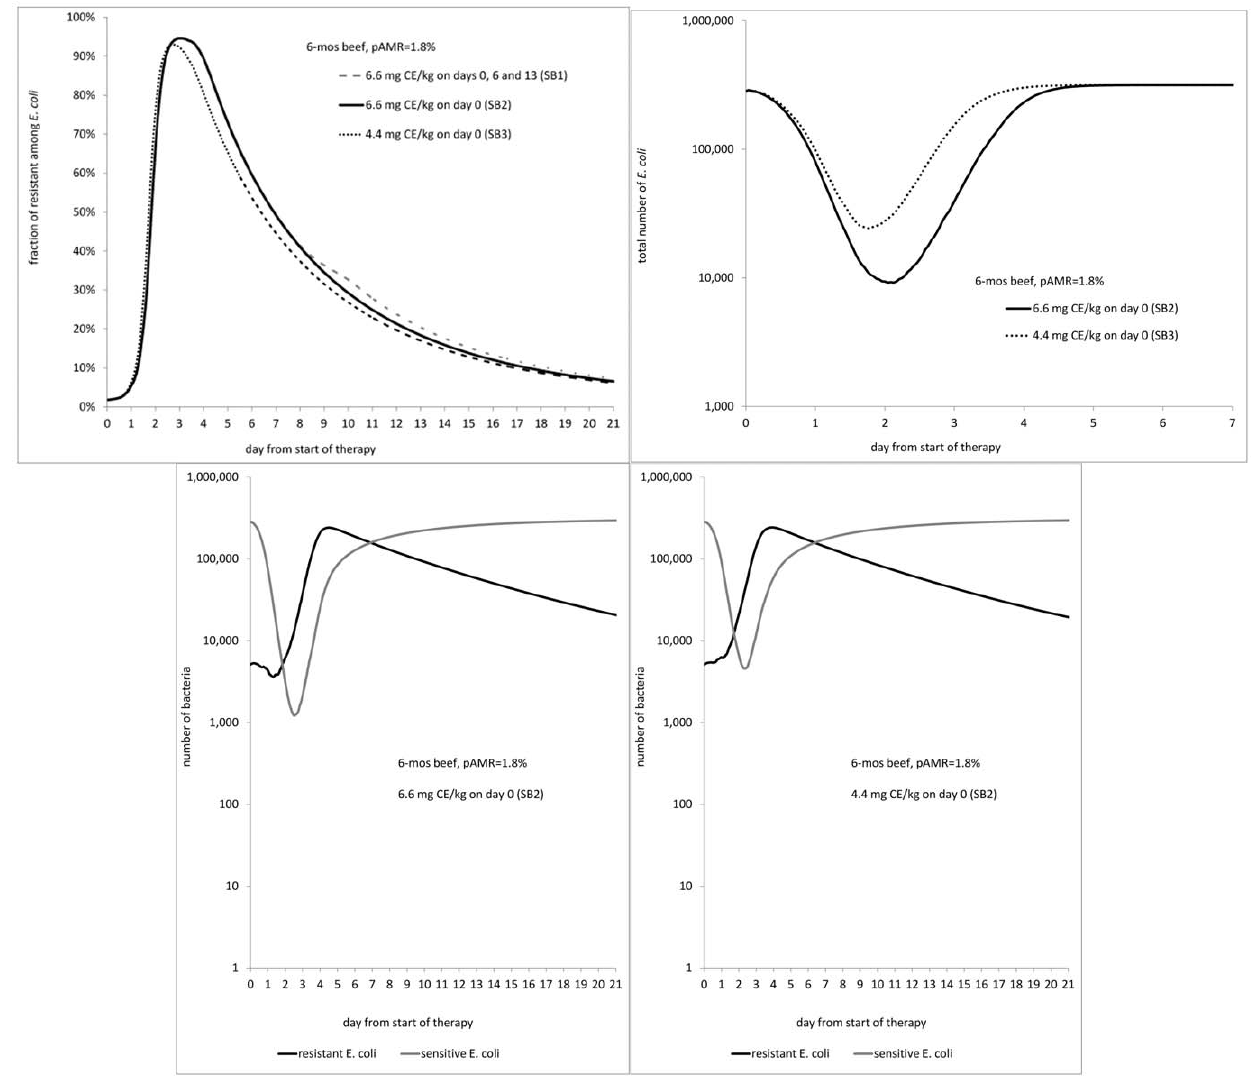
Figure 4. Effect of therapy using a sustained-release ceftiofur formulation on enteric E.coli in the deterministic case considered ( r =0.17, a =0.05, b =4 2 3 , c =0.01; all h 2 1 ). A: Fraction of ceftiofur-resistant among E. coli . B: Total number of E. coli . Dynamics of ceftiofur- sensitive and resistant E. coli in a 6-mos beef treated with C: 6.6 mg CE/kg dosage, and D: 4.4 mg CE/kg dosage. pAMR=frequency of resistance at start of